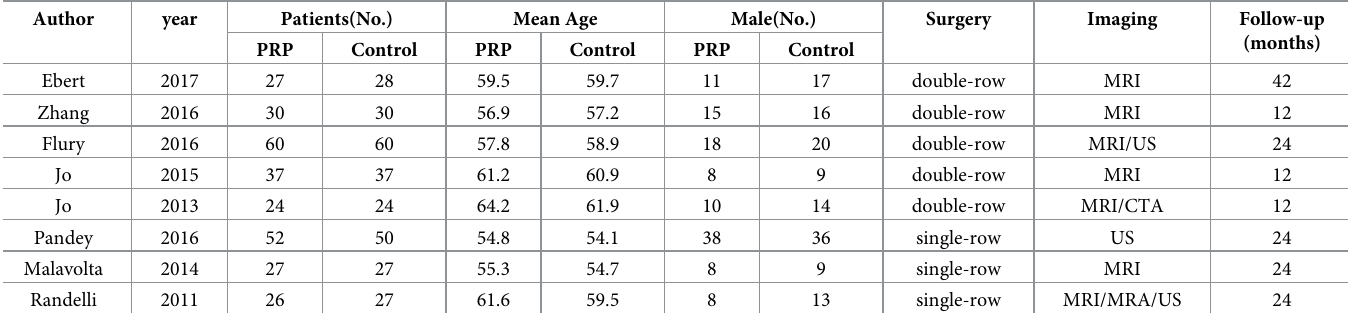
Table 1. Main characteristics of all eligible studies included in the analysis.